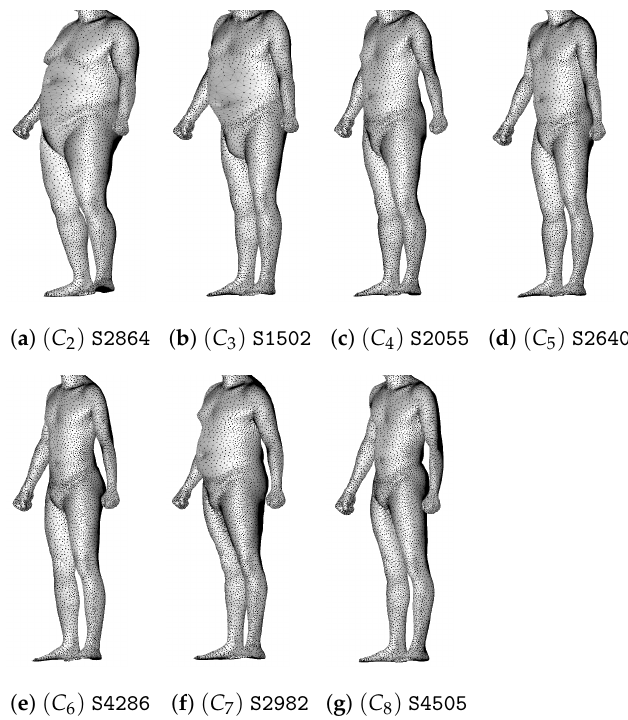
Figure 20. Medoids of clusters C 2 to C 8 of the Ward-linkage hierarchical clustering.